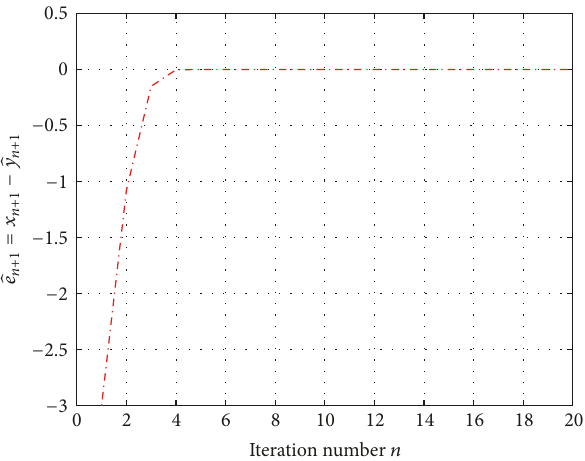
Figure 1: The trajectory of ̂𝑒 𝑛+1 with 𝜇 = 0.78 and 𝑘 𝑖 = 0.21 .